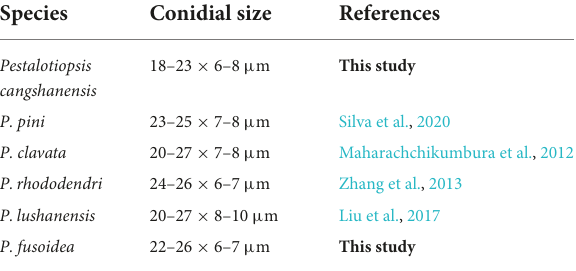
TABLE 3 Compare the conidia